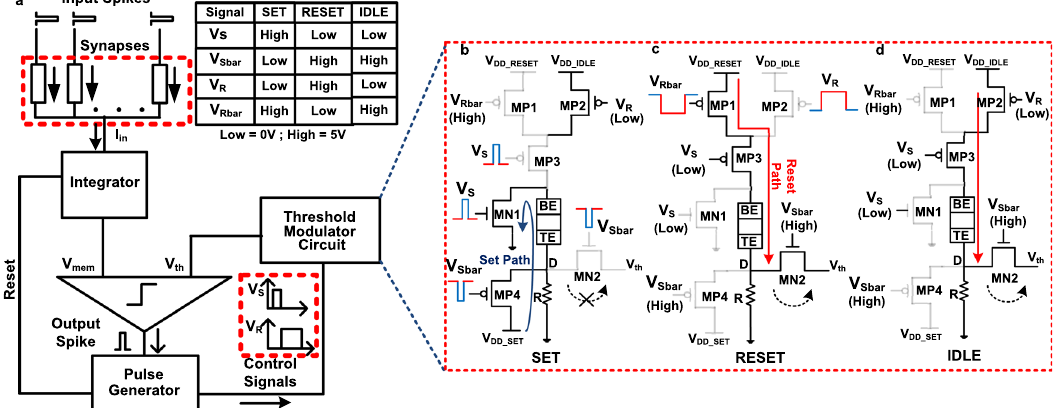
Fig. 4 Proposed DEXAT neuron threshold modulator. a Functional block diagram of proposed adaptive neuron and associated control signals generated by pulse generator in a spike event and ( b ), ( c ), ( d ) SET, RESET, and IDLE modes in our proposed 6T-1R threshold modulator circuit respectively.